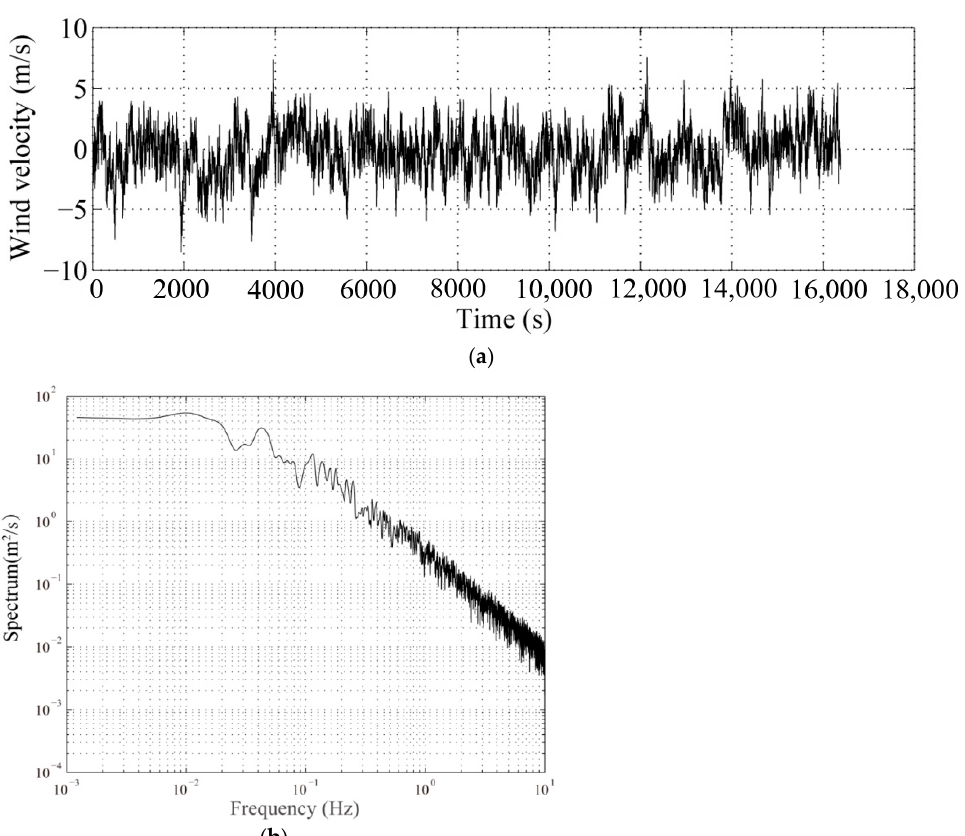
τ α tr . From Figure 3, the truncated order of k